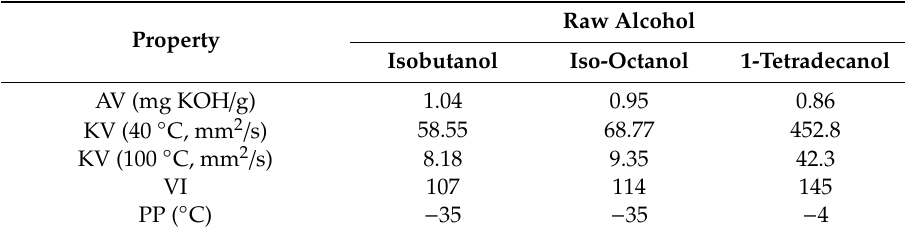
Table 2. E ff ect of raw alcohol on lubrication properties of Table 2. Effect of raw alcohol on lubrication properties of TMT.